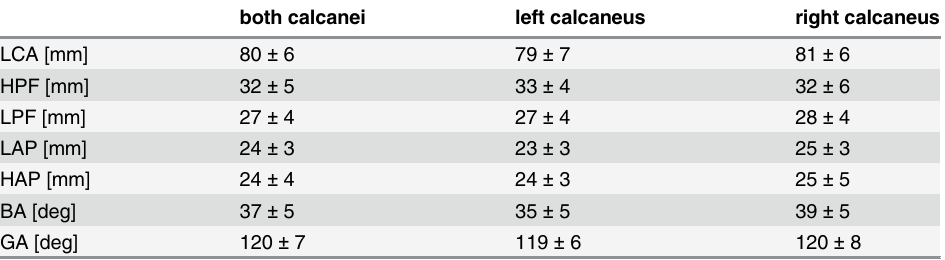
Abbreviations: the length of the calcaneal axis (LCA), the height of the posterior facet (HPF), the length of the posterior facet (LPF), the length of the anterior process (LAP), the height of the anterior process (HAP), the critical angle of Gissane (GA), the tuber angle of Böhler